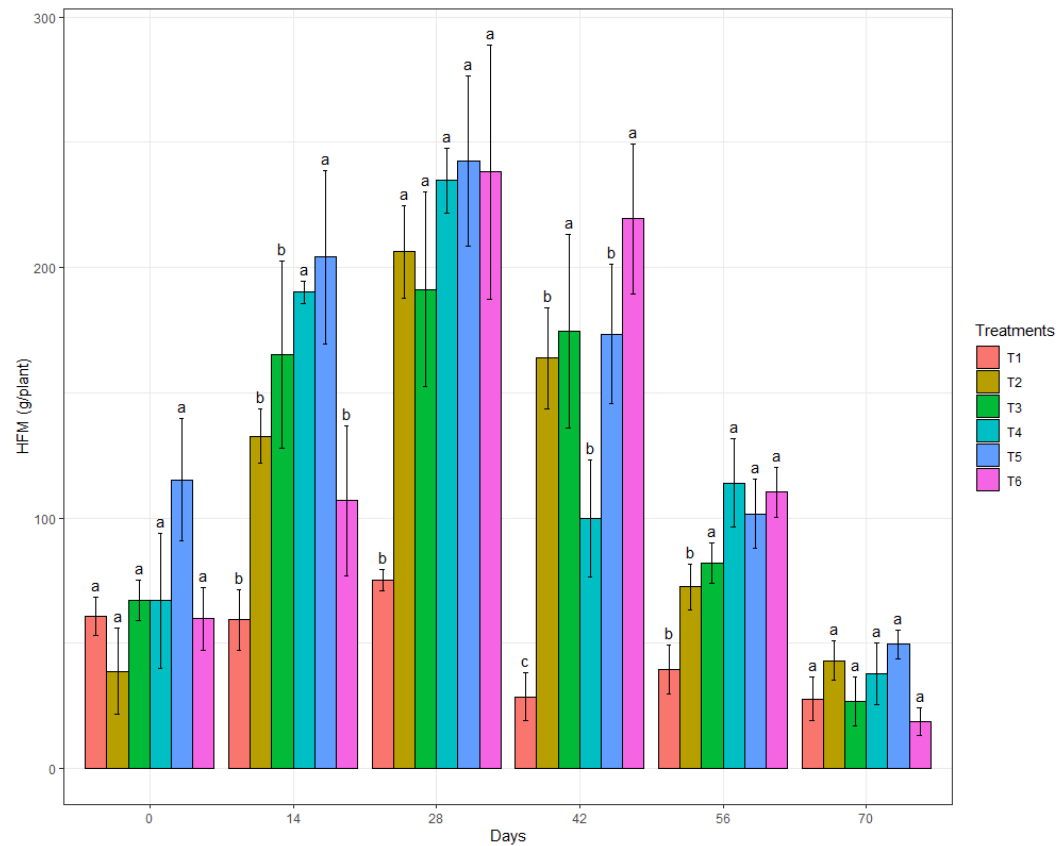
Figure 3. Mean HFM of the treatments (T1: water; T2: chemical control; T3: biological control; T4: B.BV10 1 g/L; T5: B.BV10 2 g/L; and T6: B.BV10 4 g/L) at each time of evaluation. Means in each day